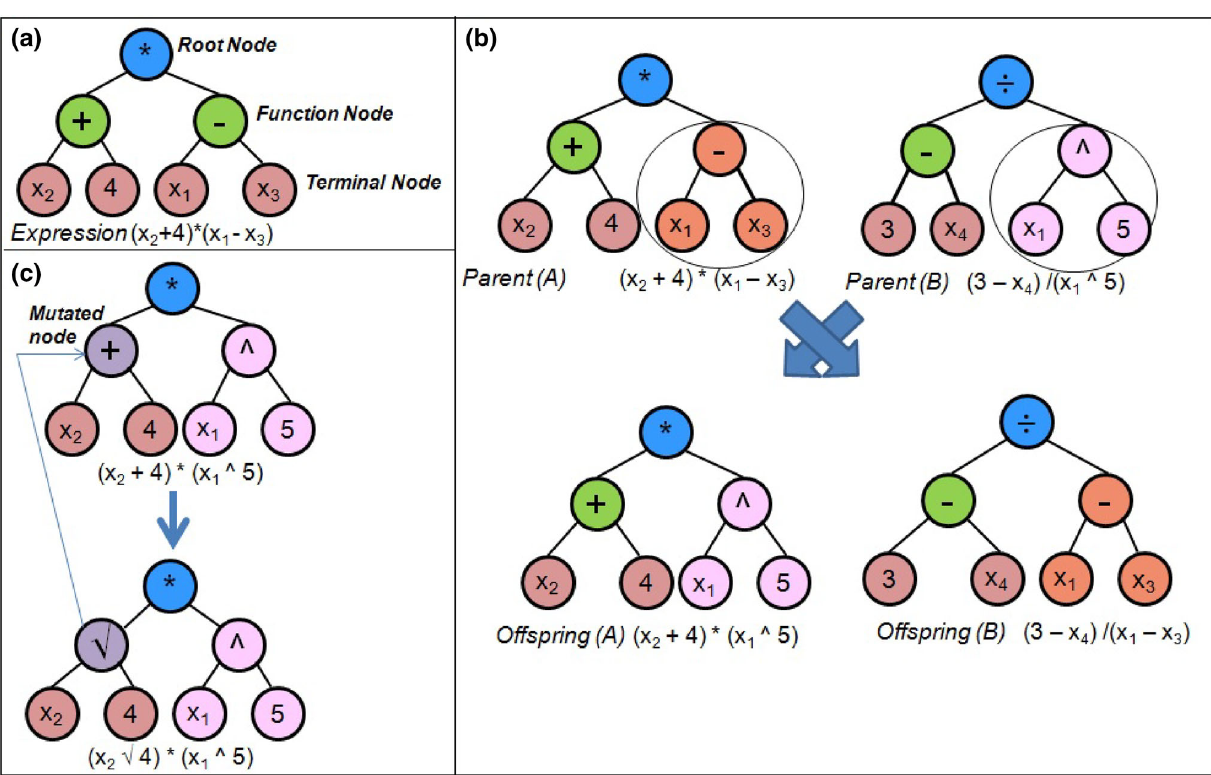
Fig. 5 Schematic diagram of: a a typical tree structure, b a crossover operation, and c a mutation operation